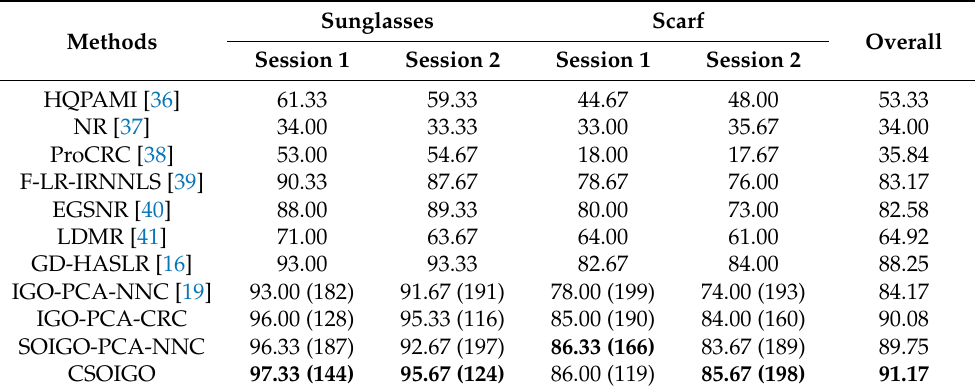
Table 2. Recognition accuracy (%) of competing approaches on a subset of the AR database (test samples contain sunglasses occlusion or scarf occlusion) when two neutral face images (from Sessions 1 and 2) per subject are used as training samples, the dimension that leads to the best result for IGO- and SOIGO-based approaches is given in